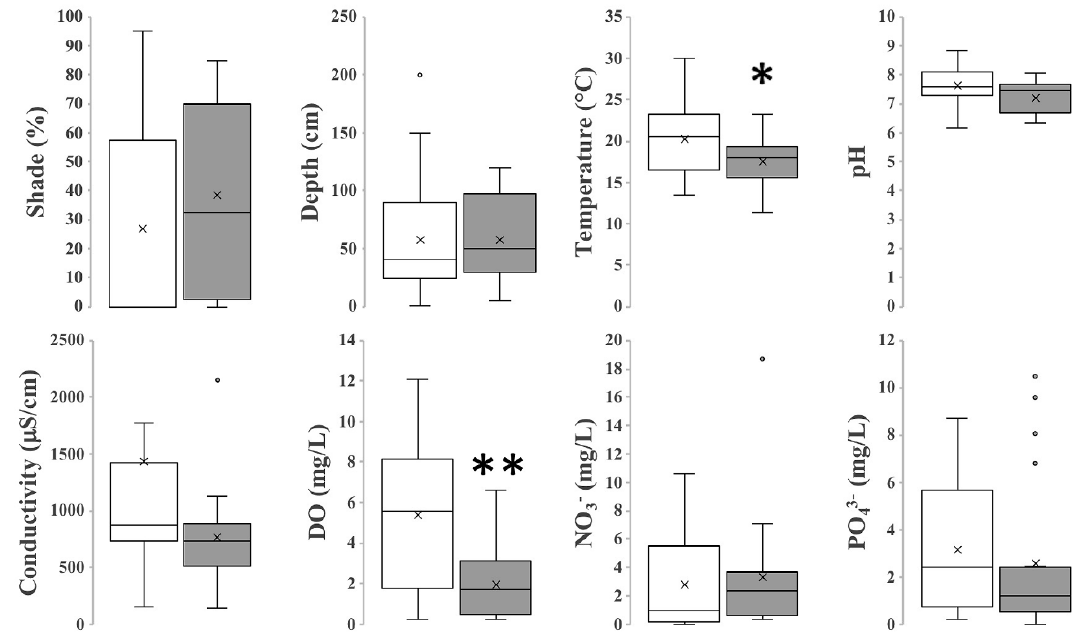
Figure 1. Ranges of the environmental variables at the sites with C. lemnata (white) and sites with L. minuta (grey). The plots show the median (line across the box), the mean (x), interquartile range (the upper and lower parts of the box), and variance beyond the quartile range (the whiskers) including the outliers (circles) (* and ** for the p < 0.05 and p < 0.005 significant differences).